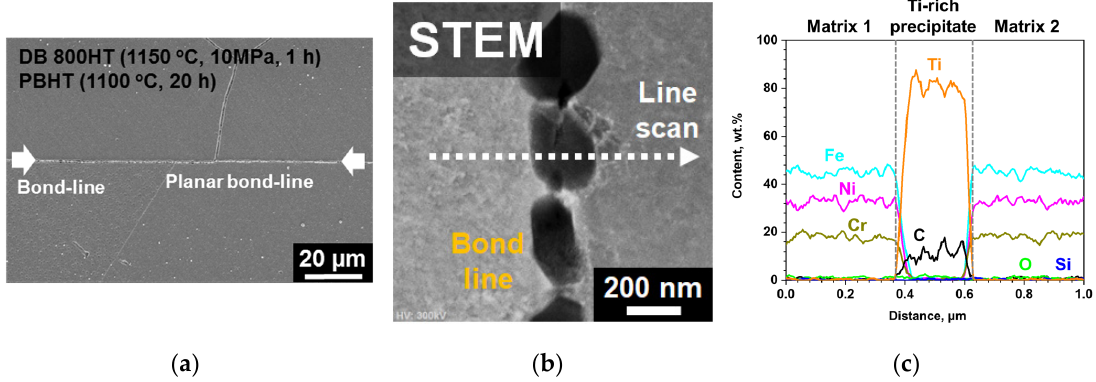
Figure 5. ( a ) SEM micrograph of PBHT-ed Alloy 800HT, and TEM analyses results at the bond-line; ( b ) STEM micrograph and ( c ) EDS line scanning.